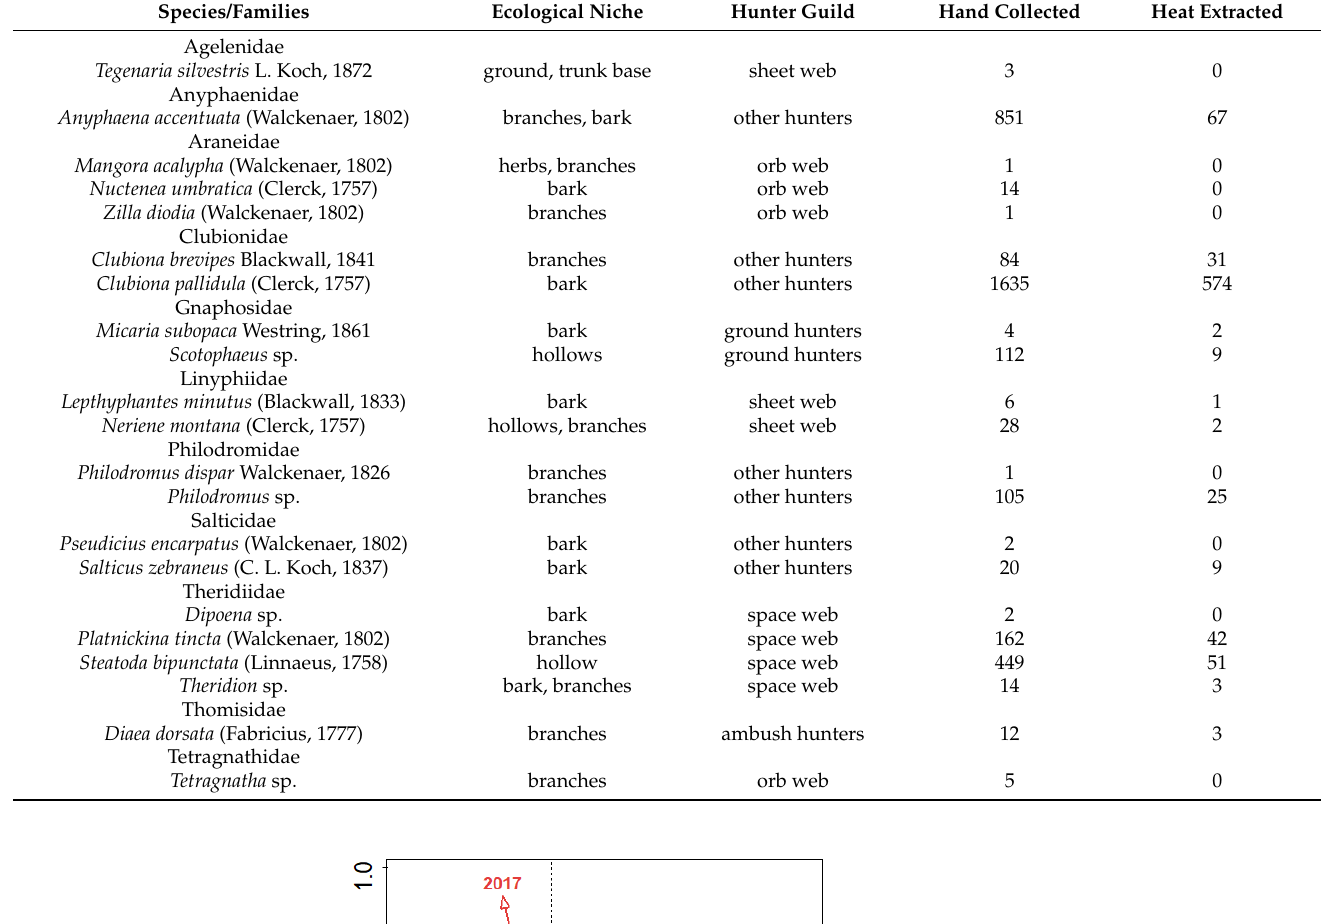
Table 1. Species list of spiders overwintering in nesting boxes and their numbers. Hand collected = number of spiders hand collected in 2015–2017, heat extracted = number of spiders heat-extracted from nest material from 39 nesting boxes in 2017.